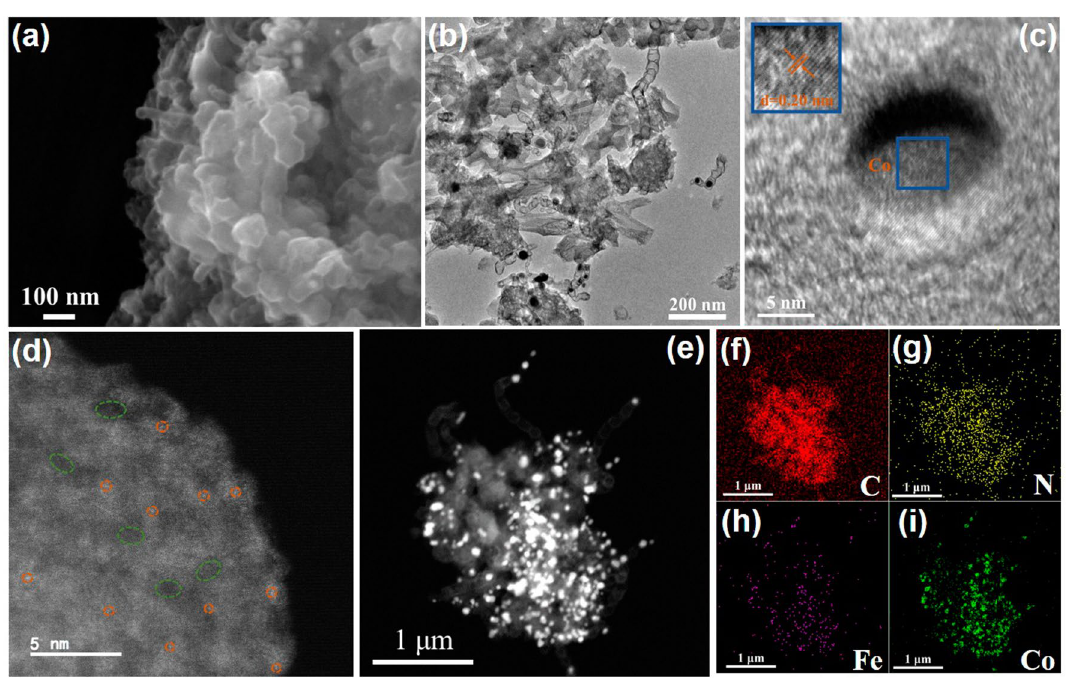
Fig. 2 a SEM images of CoNP@FeNC-0.05. b TEM and c HRTEM images of CoNP@FeNC-0.05. d AC HAADF-STEM image of CoNP@ FeNC-0.05 (orange circles: highly dispersed Fe; green circle: pores). e–i TEM image and corresponding EDS mapping of